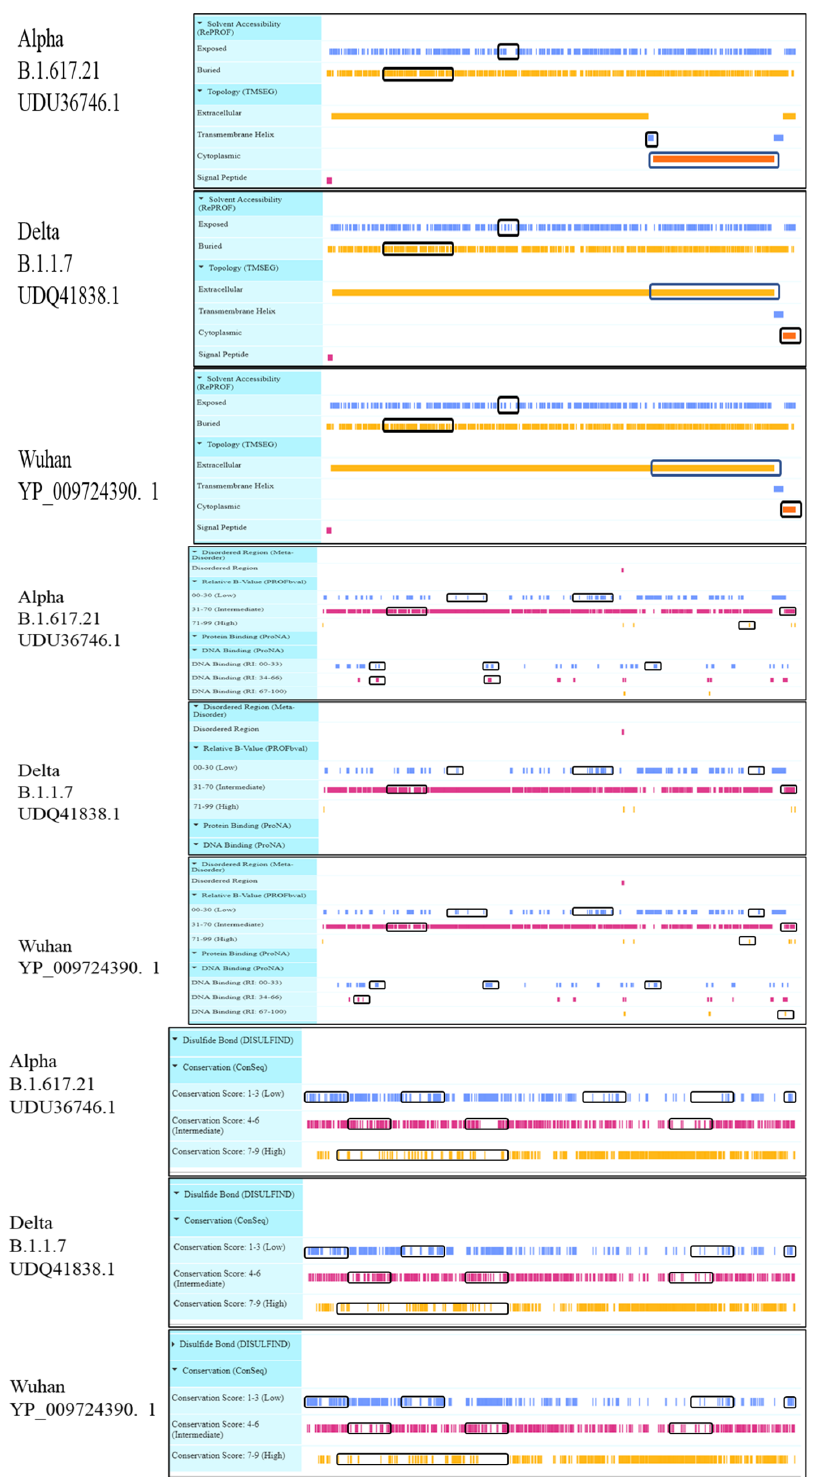
Figure 2. Viewer layout of the predicted features of the protein structural and functional features of the surface glycoproteins.